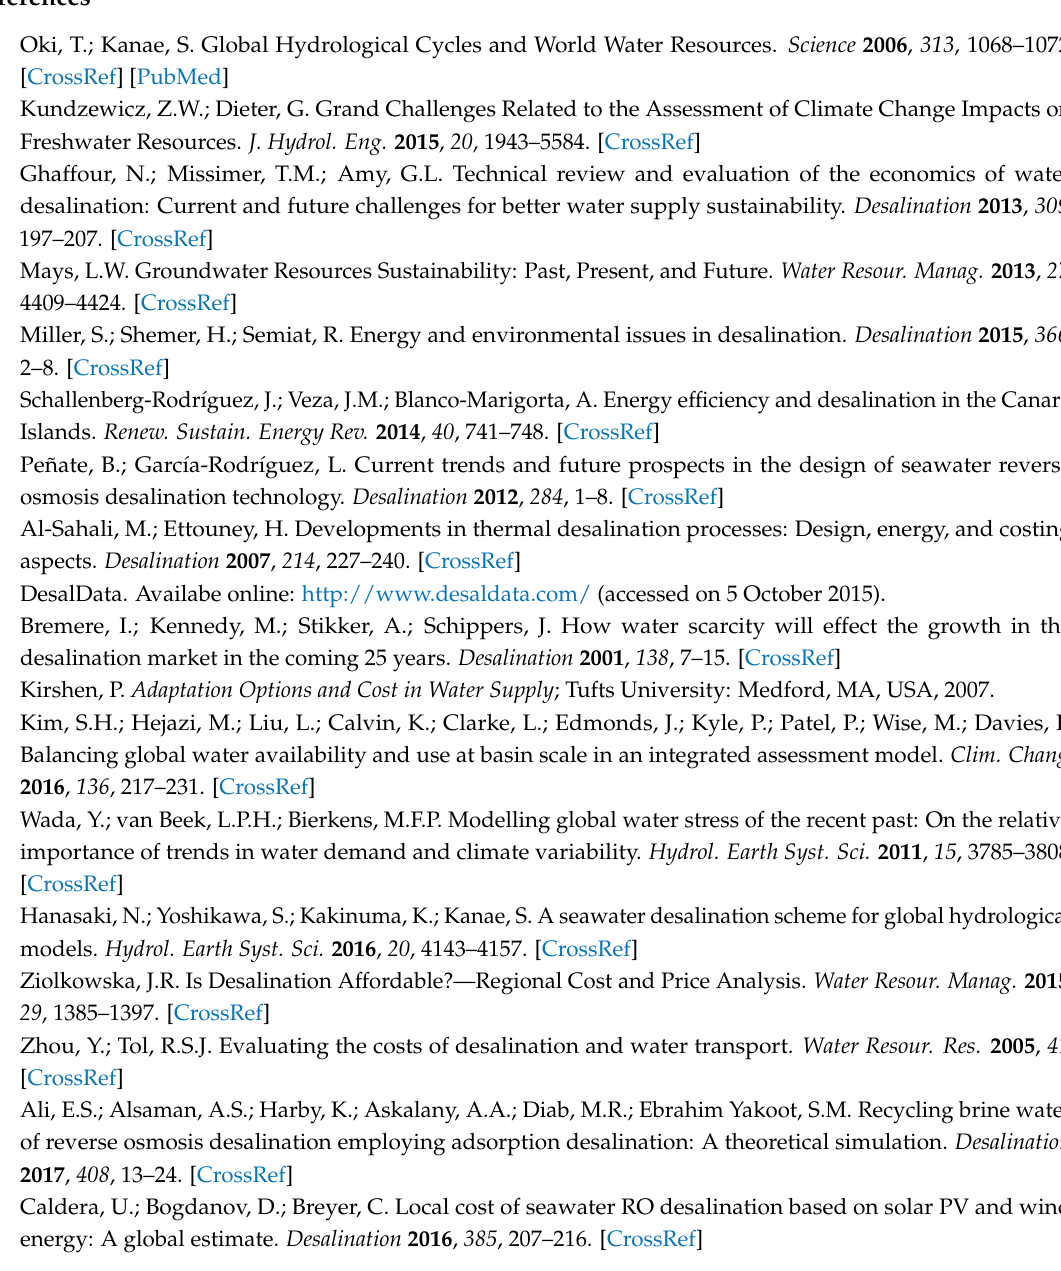
Figure S1: Correlation coefficients between various principle variables to estimate the capital cost, Figure S2: Validation of capital cost, Figure S3: Validation of water prices, Figure S4: Future projections of plant capacity, Figure S5: A world map of the projected water prices, Table S1: Data items and selection criteria, Tables S2–S5: Model’s parameters and performance results of capital cost, Table S6: Error matrix for capacity predictions of SWRO plant, Tables S7 and S8: Model’s parameters and performance results of conventional water price, and Table S9-S10: Feasibility index in past and future